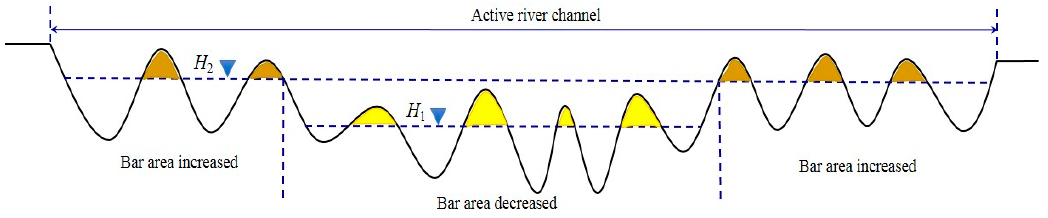
Figure 11. Schematic diagram of impacts of water level rising on braided channel within active river channel of the middle and lower Lhasa River.